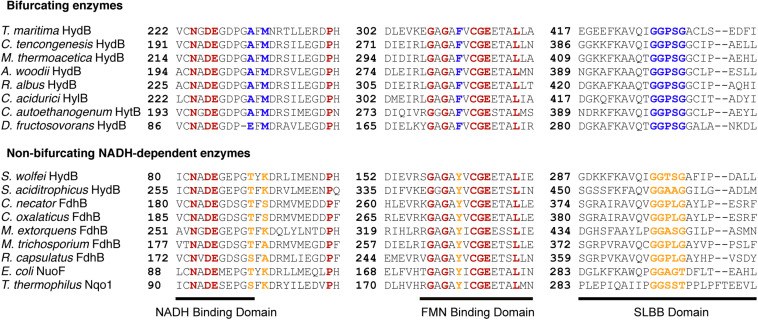
Differences in conserved residues near NADH and FMN binding-sites and the SLBB conserved region of the beta subunits of BF and non-BF NADH-dependent enzymes. The solid black line indicates residues that overlap with proposed NADH and FMN binding sites in T. thermophilus Nqo1 (Walker, 1992; Sazanov and Hinchliffe, 2006). Numbers indicate amino acid residue positions in the respective beta subunit amino acid sequences. Red highlights amino acid residues that are conserved in all 17 sequences. Blue highlights residue positions that are conserved in BF beta subunits. Yellow highlights the equivalent residues from alignments of beta subunits from non-BF NADH-dependent enzymes.